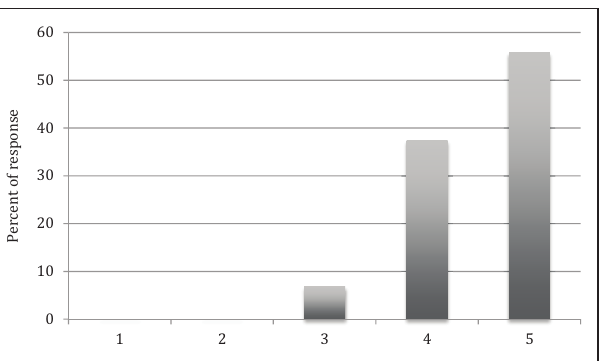
Figure 3) Per cent of response to ‘I had an interest in gastroenterology